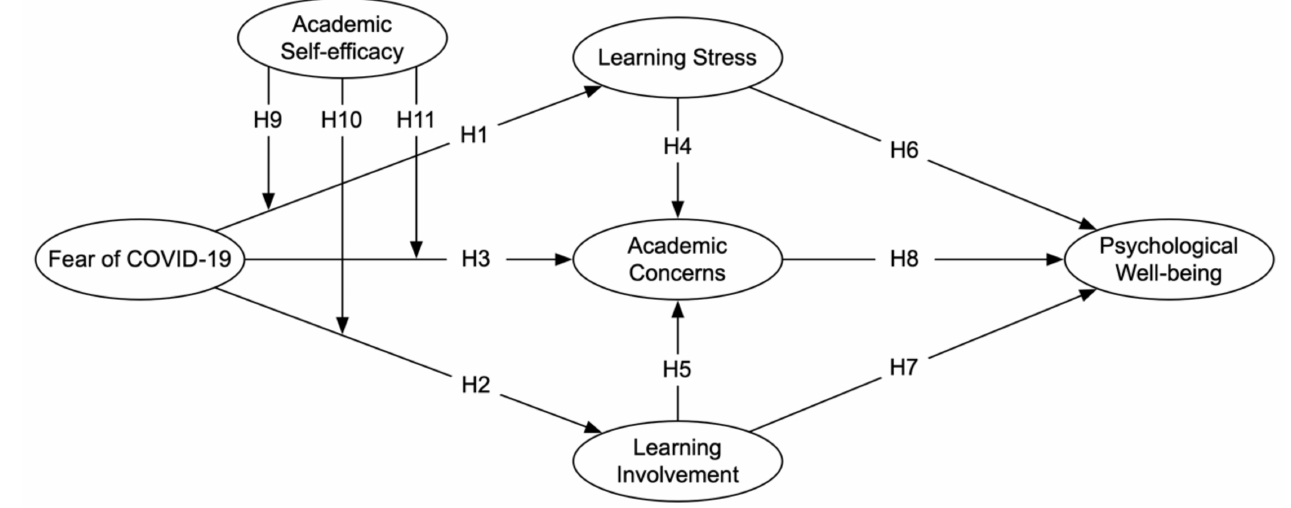
Figure 1. Conceptual